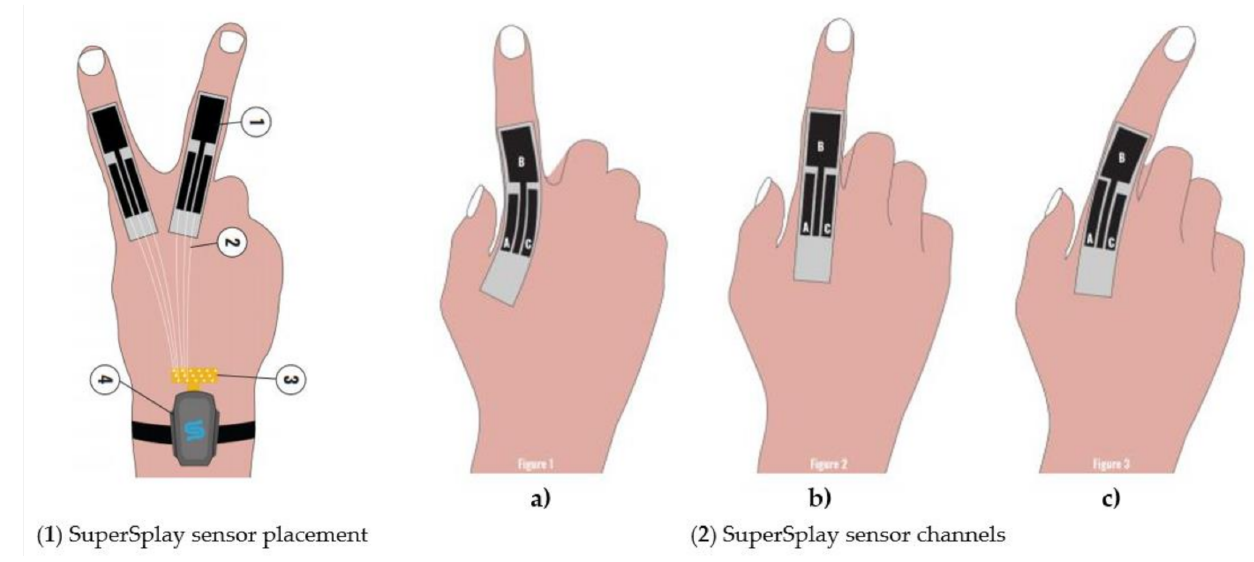
Figure 15. StretchSense sensor illustration